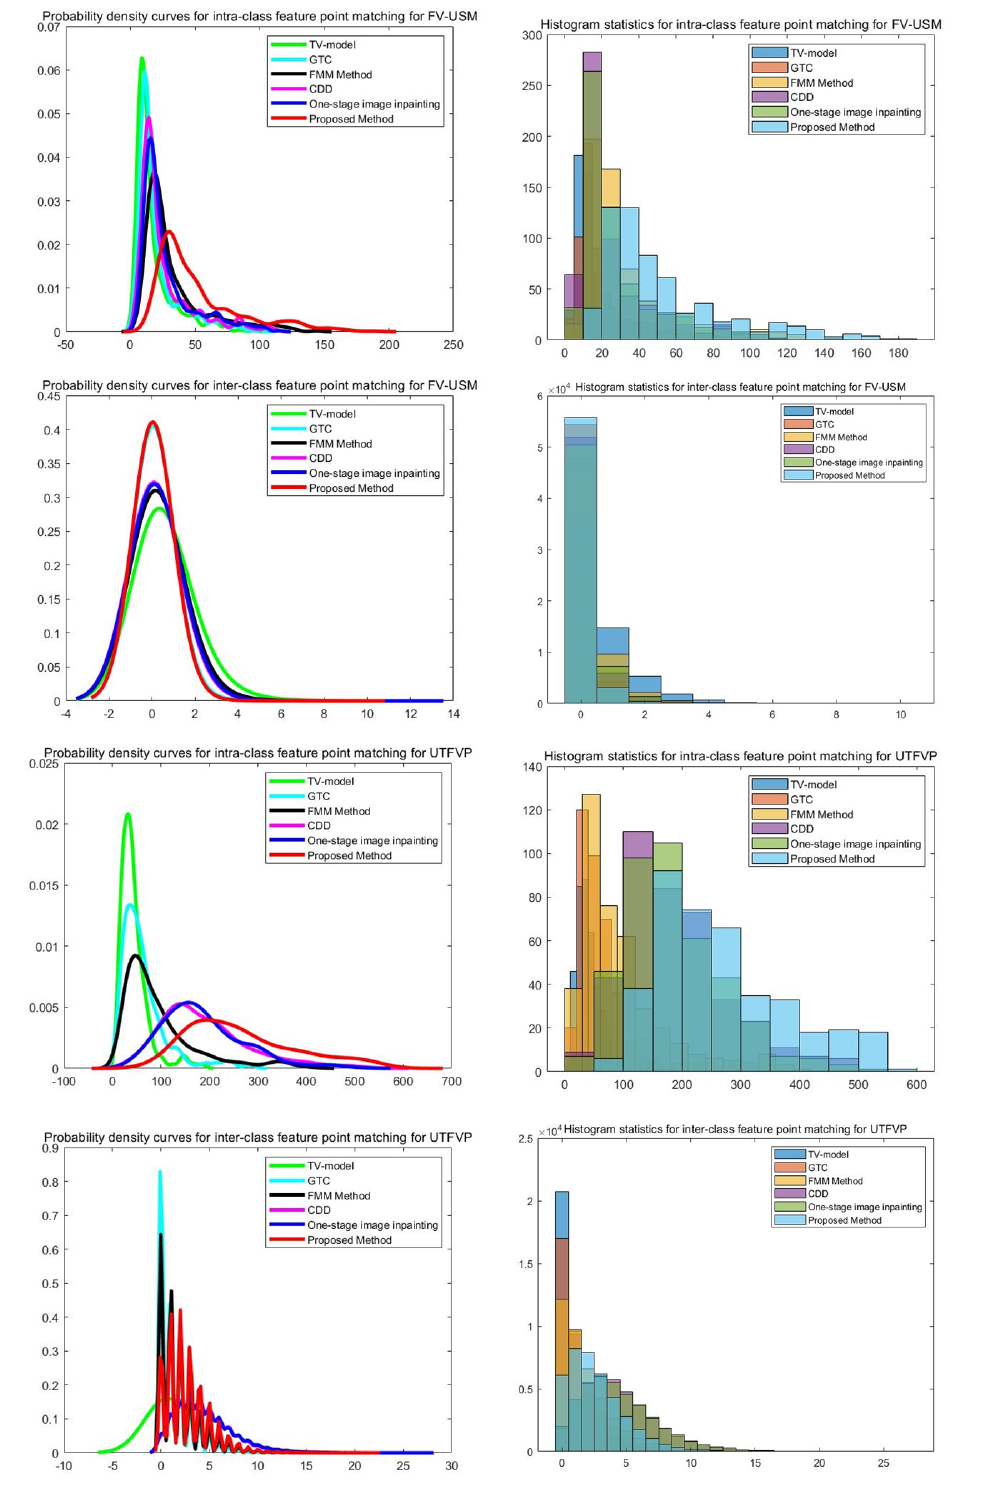
Figure 11. The intra-class and inter-class probability density distribution plots and feature point histogram statistical plots of various image restored methods on the UTFVP and FV-USM